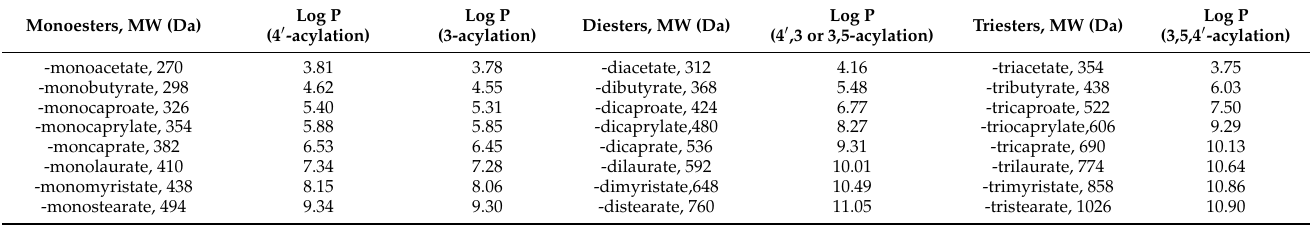
Table 3. Lipophilicity and MW (molecular weight) of resveratrol esters a